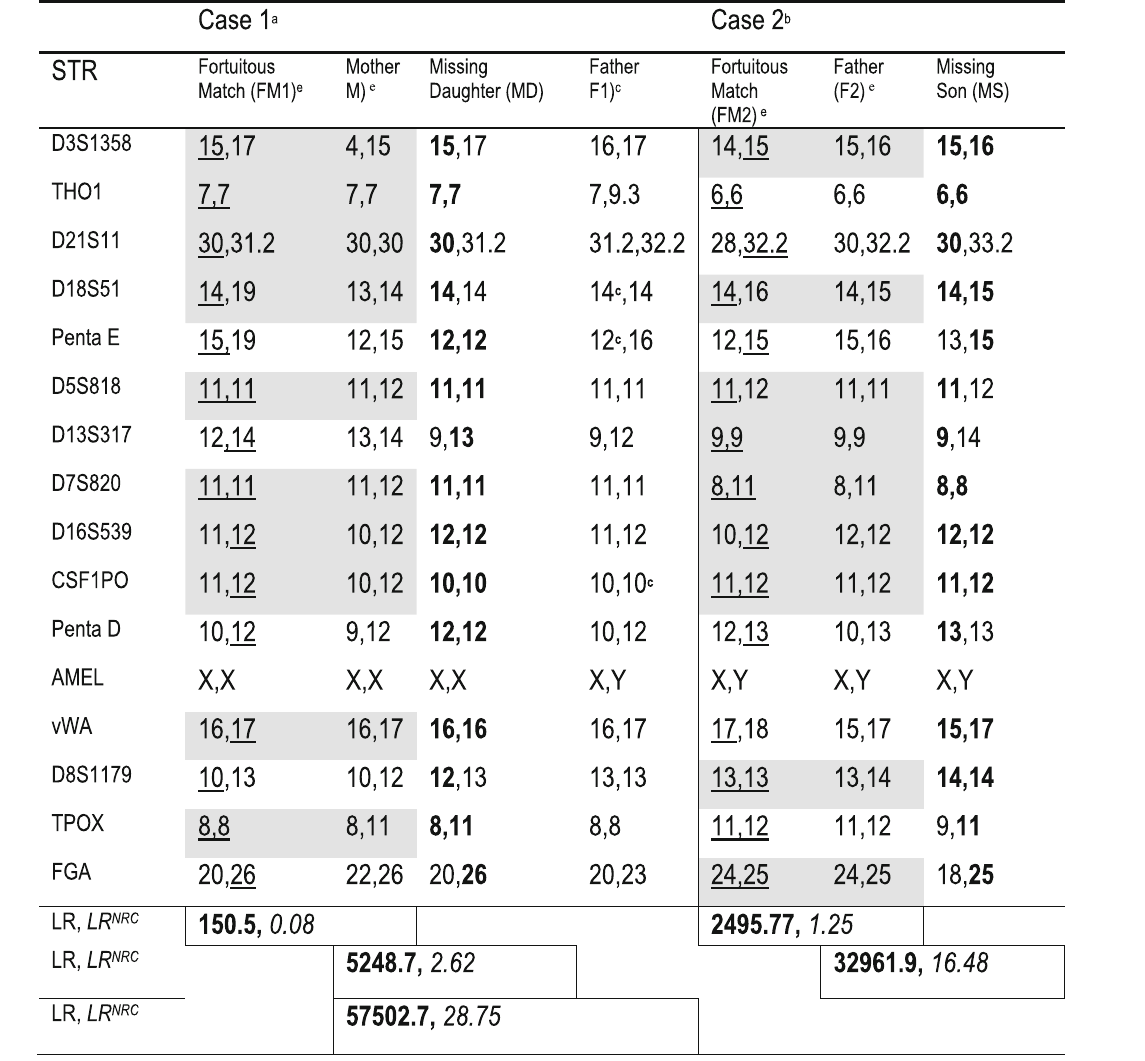
Table 1 Cases of fortuitous matches (FM) with 15 STRs versus – presumably – real kinship between a mother (M) and/or father (F) searching a missing daughter (MD) and missing son (MS),